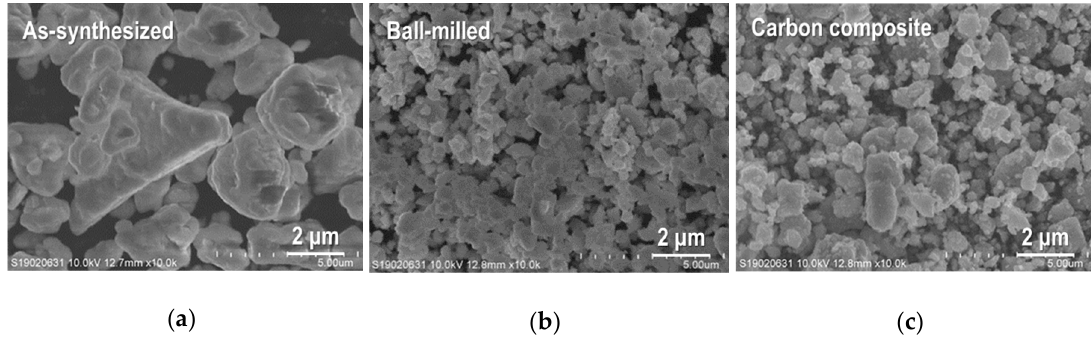
Figure 2. Scanning electron microscopy (SEM) images for ( a ) as‐synthesized Sn 4 P 3 powder, ( b ) ball‐ milled Sn 4 P 3 powder and ( c ) Sn 4 P 3 /C composite powder.